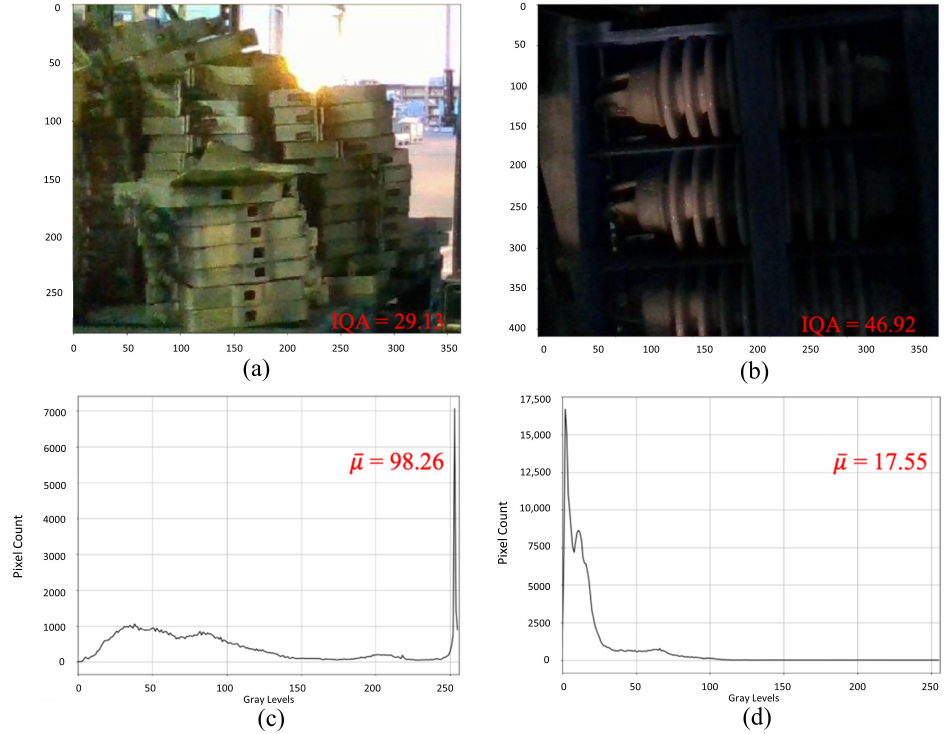
Figure 3. IQA score for ( a ) brace bands and ( b ) insulators, and histogram for brace bands ( c ) and ( d )